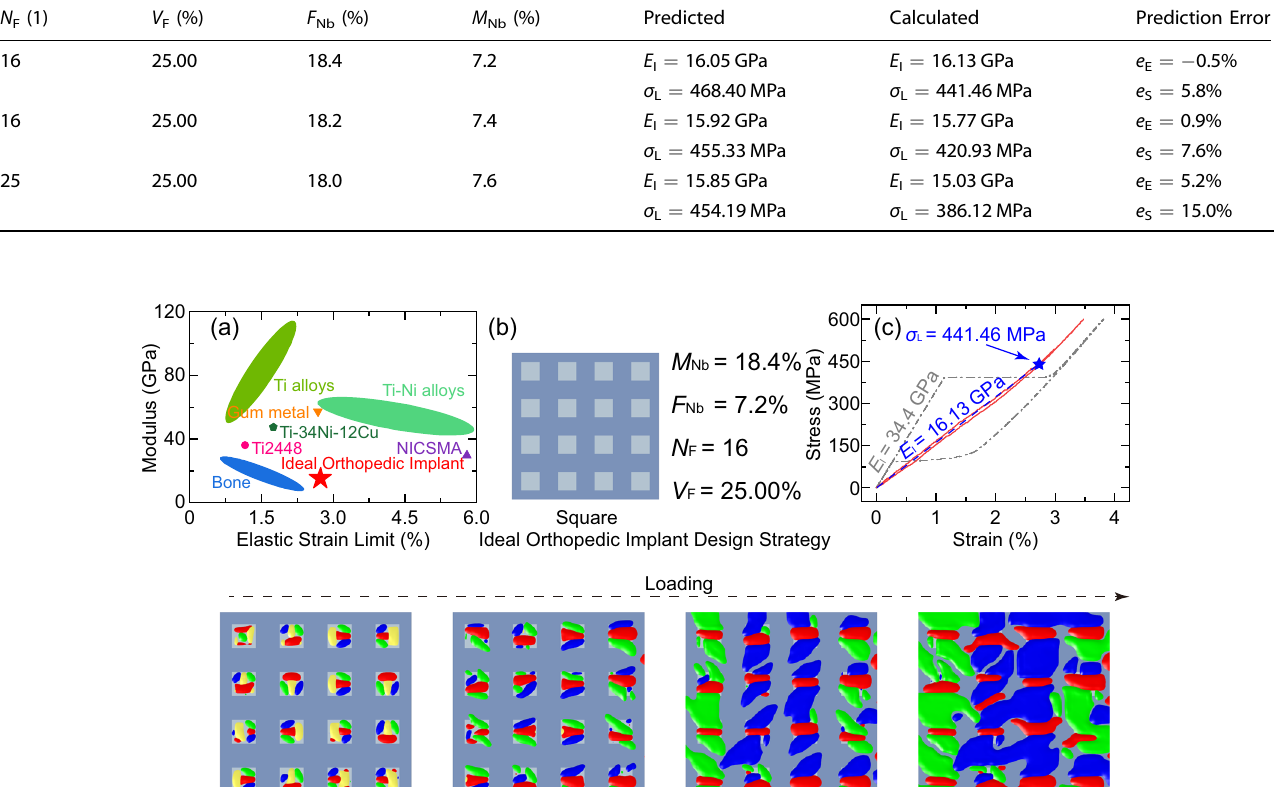
Table 1. Predicted and calculated value of properties of new